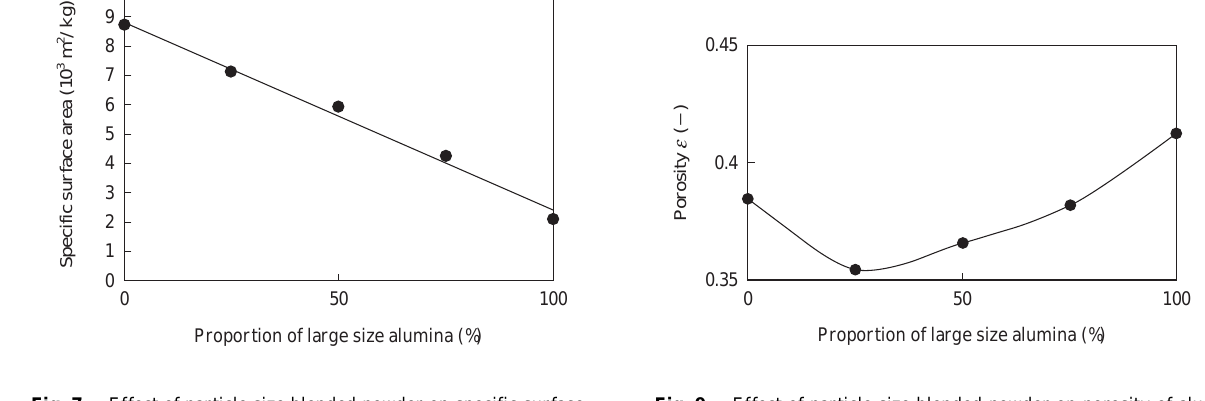
Effect of particle size blended powder on specific surface area